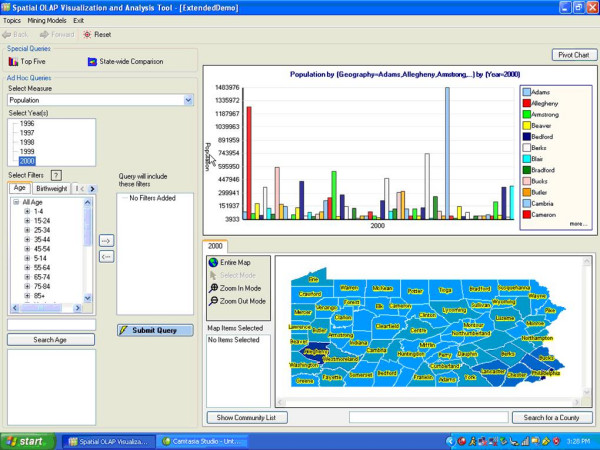
SOVAT interface.